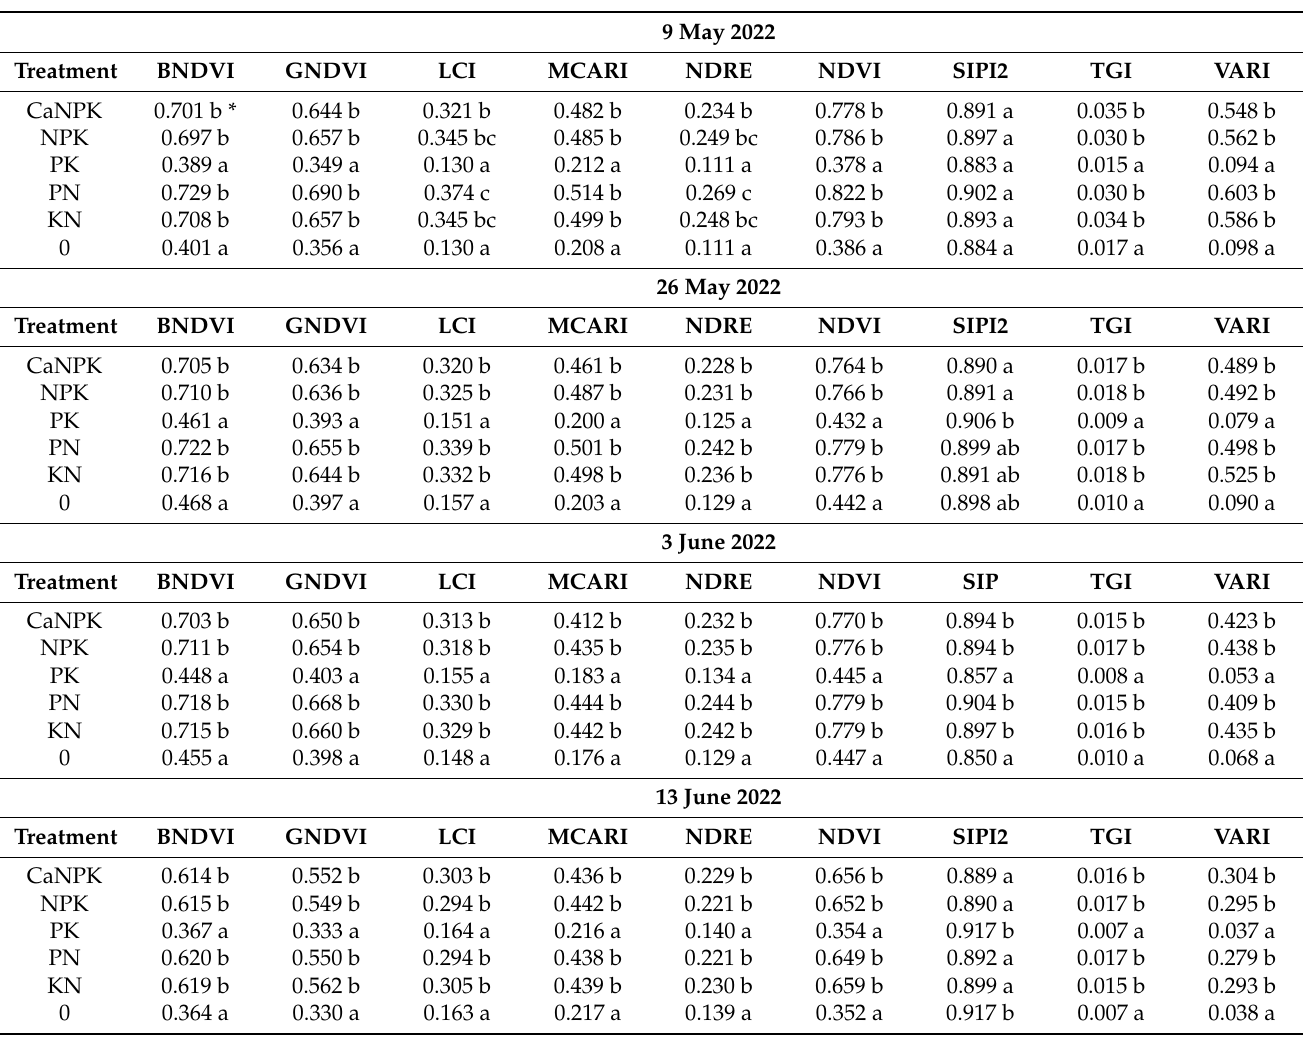
* different letters within column indicate significant differences between the means at 0.05 significance level. Abbreviations: NDVI—Normalized Difference Vegetation Index, NDRE—Normalized Difference Red Edge Index, VARI—Visible Atmospherically Resistant Index, TGI—Triangular Greenness Index, SIPI2—Structure Insensitive Pigment Index 2, LCI—Leaf Chlorophyll Index, BNDVI—Blue Normalized Difference Vegetation Index, GNDVI—